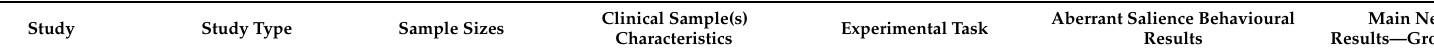
Table 1. Studies on aberrant